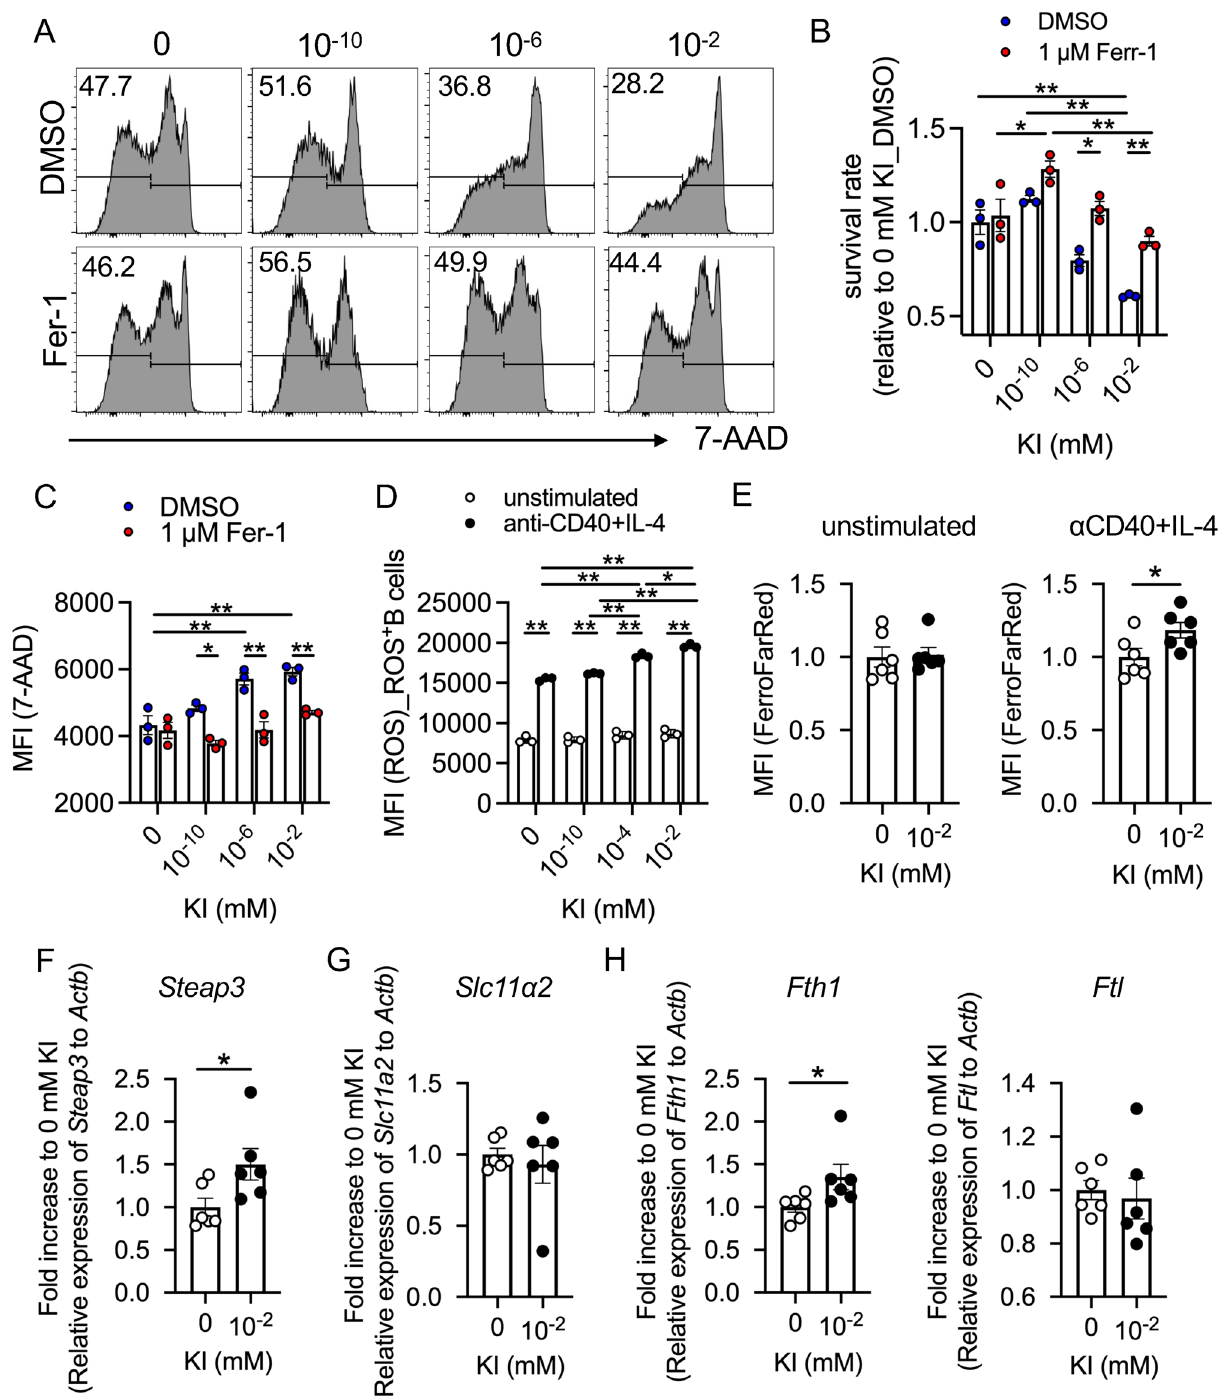
Figure 5. KI promotes ferroptosis of activated B cells. Splenic B cells collected from C57BL/6 J mice were cultured with anti-CD40 antibody, IL-4, and serially diluted KI for three days. ( A ) Histogram of 7-ADD expression in B cells stimulated with DMSO or Fer-1. ( B , C ) Survival rate ( B ) and MFI of 7-AAD ( C ) in stimulated B cells with DMSO or Fer-1. Representative data from two independent experiments are shown as the mean ± SD ( n = 3 for each point). ( D ) MFI of ROS in the ROS + B220 + CD45 + B cells. Representative data from two independent experiments are shown as the mean ± SD ( n = 3 for each point). ( E ) Intracellular ferrous iron measurements in FerroFarRed + cells cultured with or without anti-CD40 and IL-4 for 3 days. ( F – I ) Quantitative polymerase chain reaction analysis of the relative expression levels of Steap3 ( F ), Slc11a2 ( G ), Fth1 , and Ftl1 ( H ) in anti-CD40-stimulated B cells. Data were pooled from two independent experiments and are shown as mean ± SEM ( n = 6 for each point). Welch’s t -test. n.s.: not significant, * p < 0.05, ** p < 0.01. IL, interleukin; KI, potassium iodide; MFI, mean fluorescence intensity; ROS, reactive oxygen